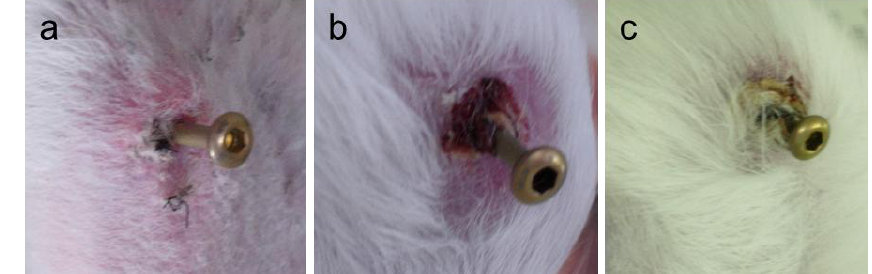
Figure 4. Typical appearances of pin-tract infection four weeks after the operation. Grade 0v: No redness, discharge, or pin loosening ( a ); Grade 1v: Redness and discharge around the pin but no pin loosening ( b ); Grade 2v: Redness and discharge around the pin, with pin loosening due to osteomyelitis ( c